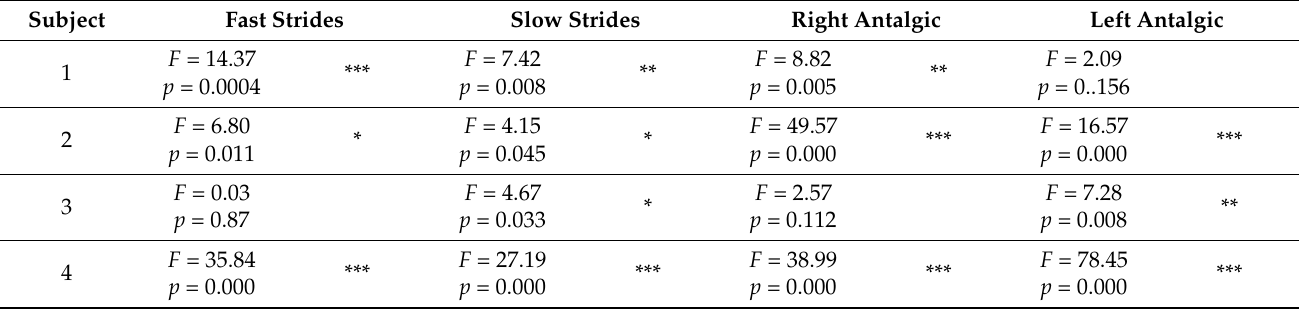
Table 9. Detection of Abnormal or Irregular Strides Using Leg Gap Variability (Levene’s test, with outliers